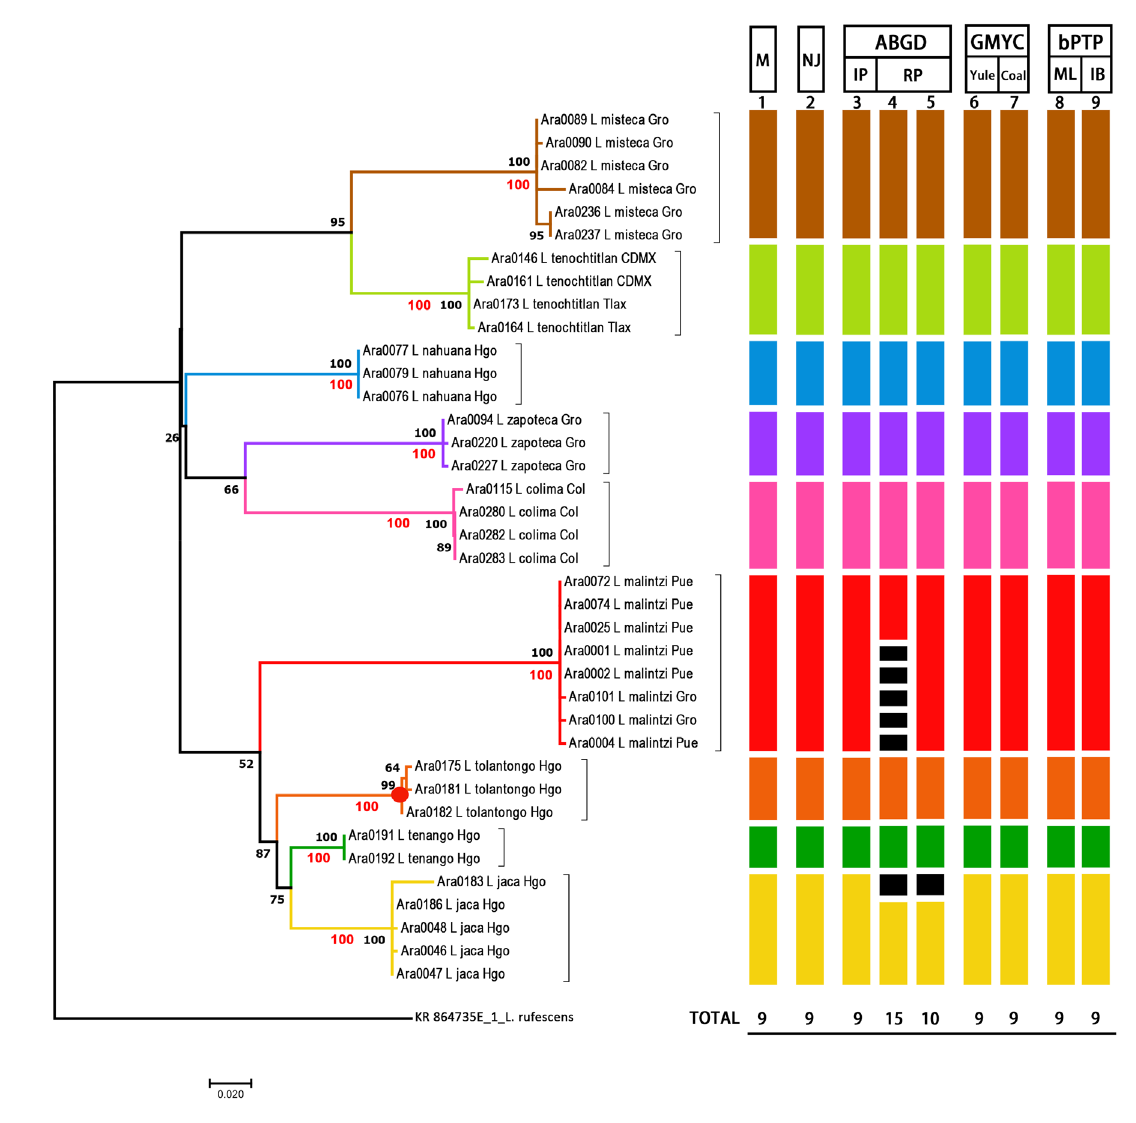
Fig. 56. Maximum likelihood tree inferred from the concatenated matrix ( CO1 + ITS2 ) of species of Loxosceles Heineken & Lowe, 1832 from Mexico. Colors of branches and bars indicate different species. Numbers above bars represent the delimitation methods: 1 = morphology (M); 2 = neighbor joining (NJ); 3 = ABGD with initial partitions (IP); 4–5 = ABGD with recursive partitions (RP); 6 = GMYC yule analysis; 7 = GMYC coalescent analysis; 8 bPTP with ML; 9 = bPTP with IB. Numbers below bars represent species recovered for each delimitation method. Red numbers correspond to Bayesian posterior probabilities, black numbers are bootstrap support values from the ML